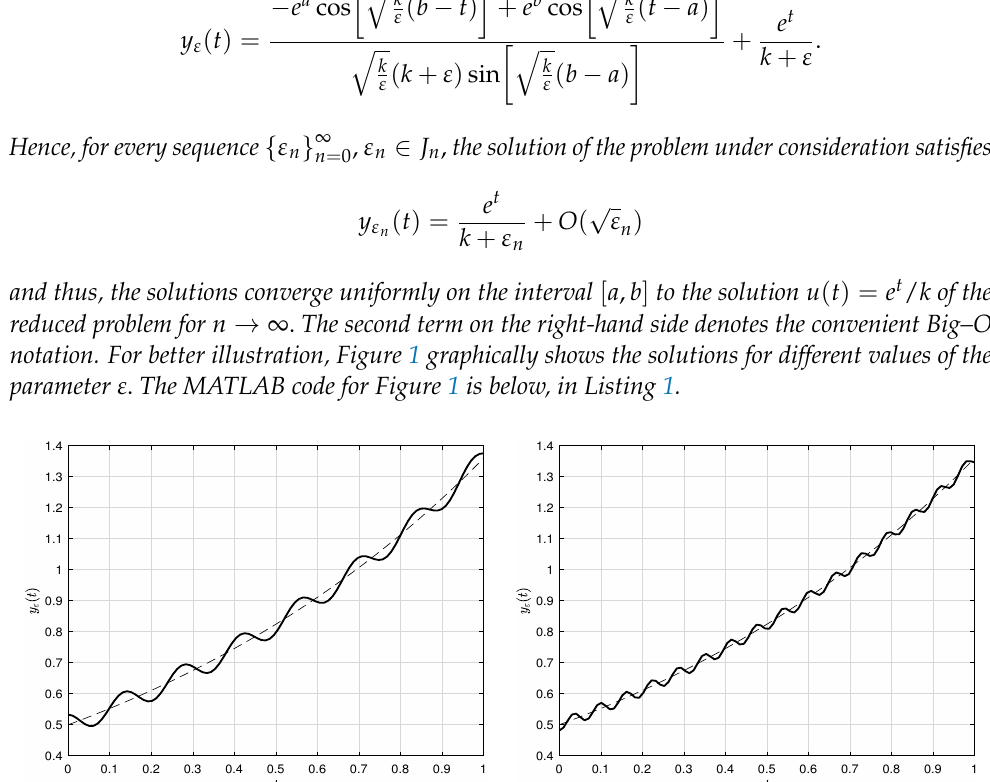
Figure 1. Solutions of the Neumann boundary value problem from Example 1 on the interval [ 0,1 ] for k = 2 and ε = 0.001 ( left ) and ε = 0.0002 ( right ). A dashed line is used to draw the function u ( t ) = e t / k , the solution of the reduced